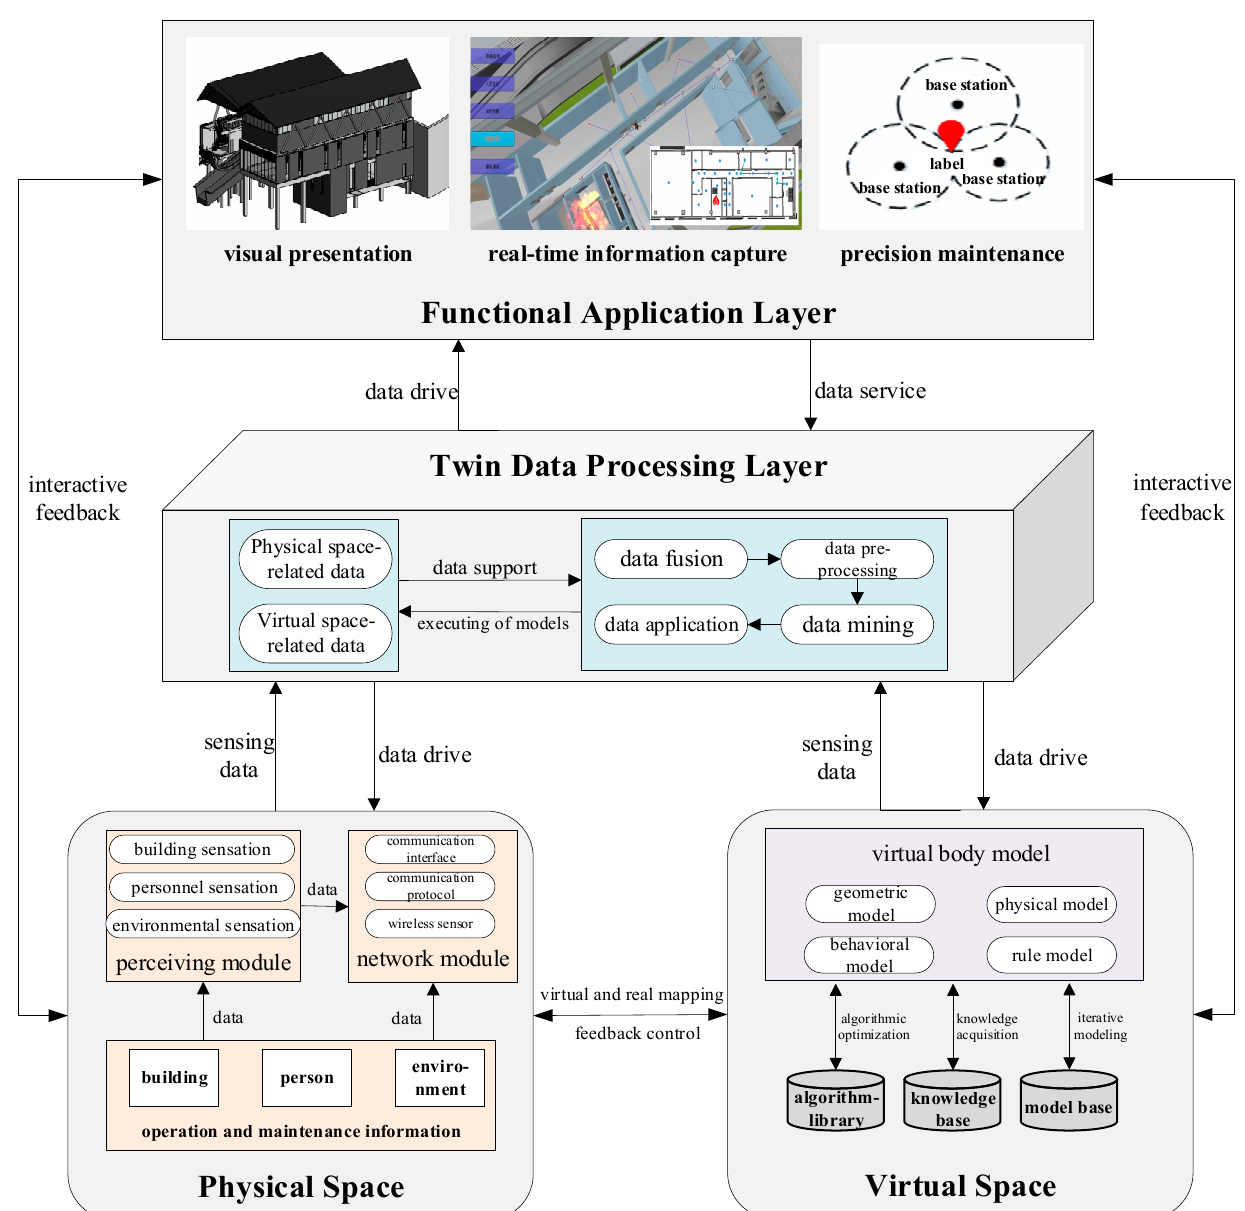
Figure 5. Multidimensional model for intelligent O&M.